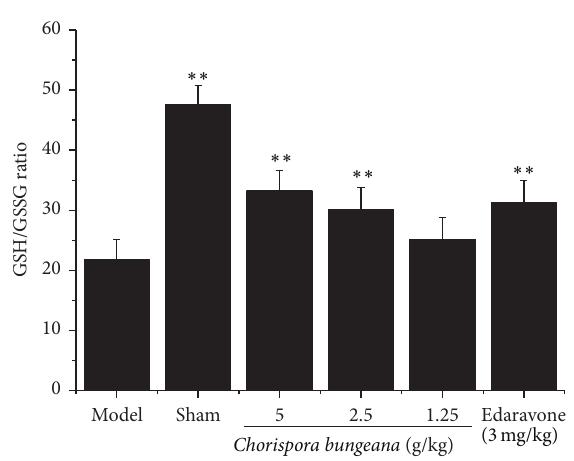
Figure 2: Effect of Chorispora bungeana water extract on GSH/ GSSG ratio in mice subjected to cerebral ischemia/reperfusion. Data were expressed as mean ± S.M.E. Differences were considered significant at 𝑃 < 0.05 . ∗ 𝑃 < 0.05 versus model group. ∗∗ 𝑃 < 0.01 versus model group.